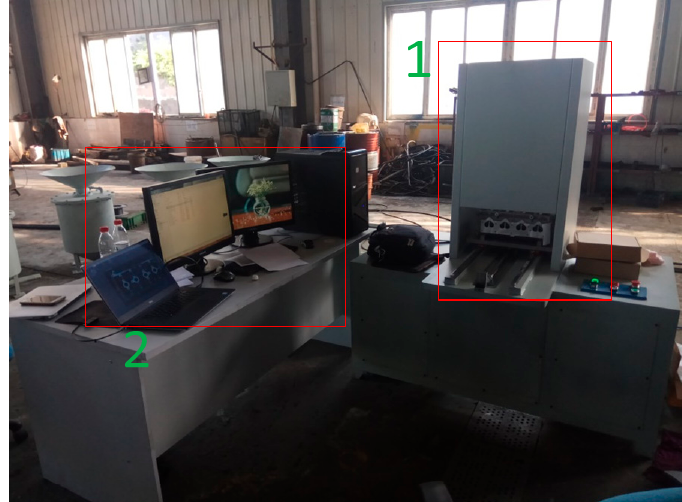
Figure 8. Experimental platform for visual inspection of engine cylinder head.